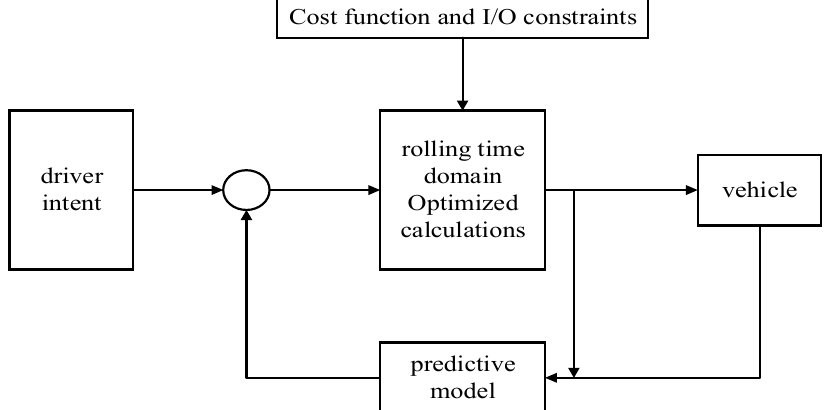
Figure 13. Structure diagram of four-wheel independent drive control system.